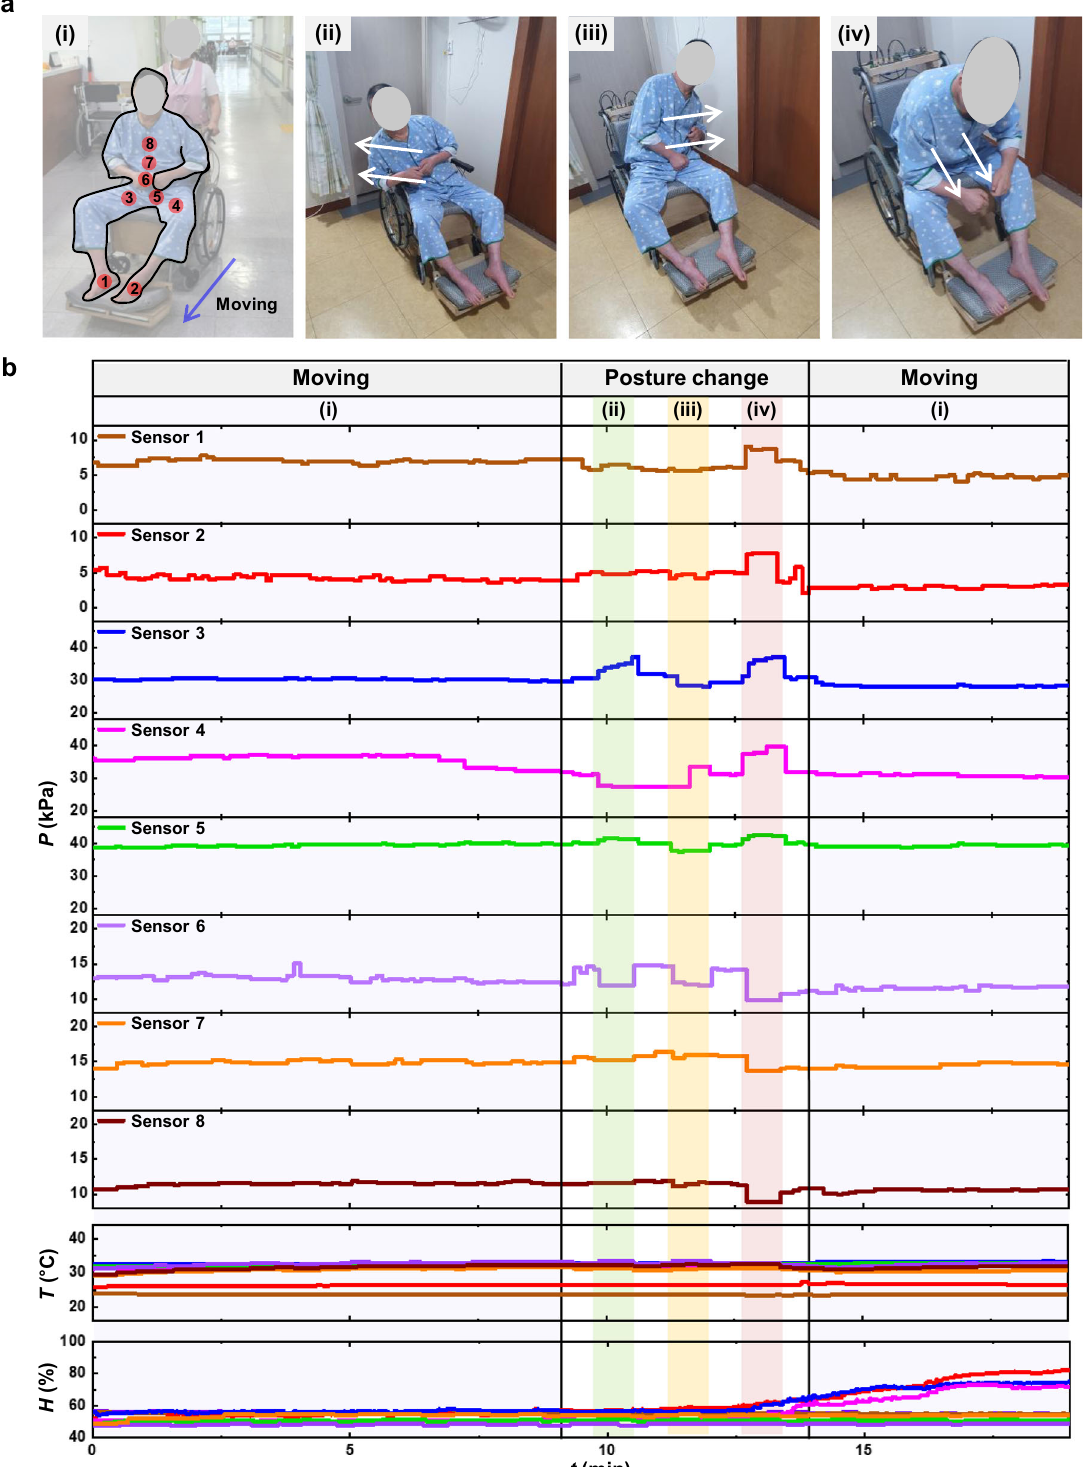
Fig. 6 Continuous measurement of pressure, temperature, and hydration from a hospitalized, paraplegic patient with spinal cord injury. a Photographs of wheelchair moving and postural changes of the subject for self-repositioning. (i) Indoor moving with the caregiver in the hospital. Red discs mark the mounting locations of the devices. (ii) Right-side lateral weight shift. (iii) Left-side lateral weight shift. (iv) Anterior weight shift. b Results from continuous measurements of pressure, temperature, and hydration from each of the sensors while moving or stationary weight-shift in the wheelchair. The subject agreed with the distribution of these photographs using a content form in Supplementary Fig.